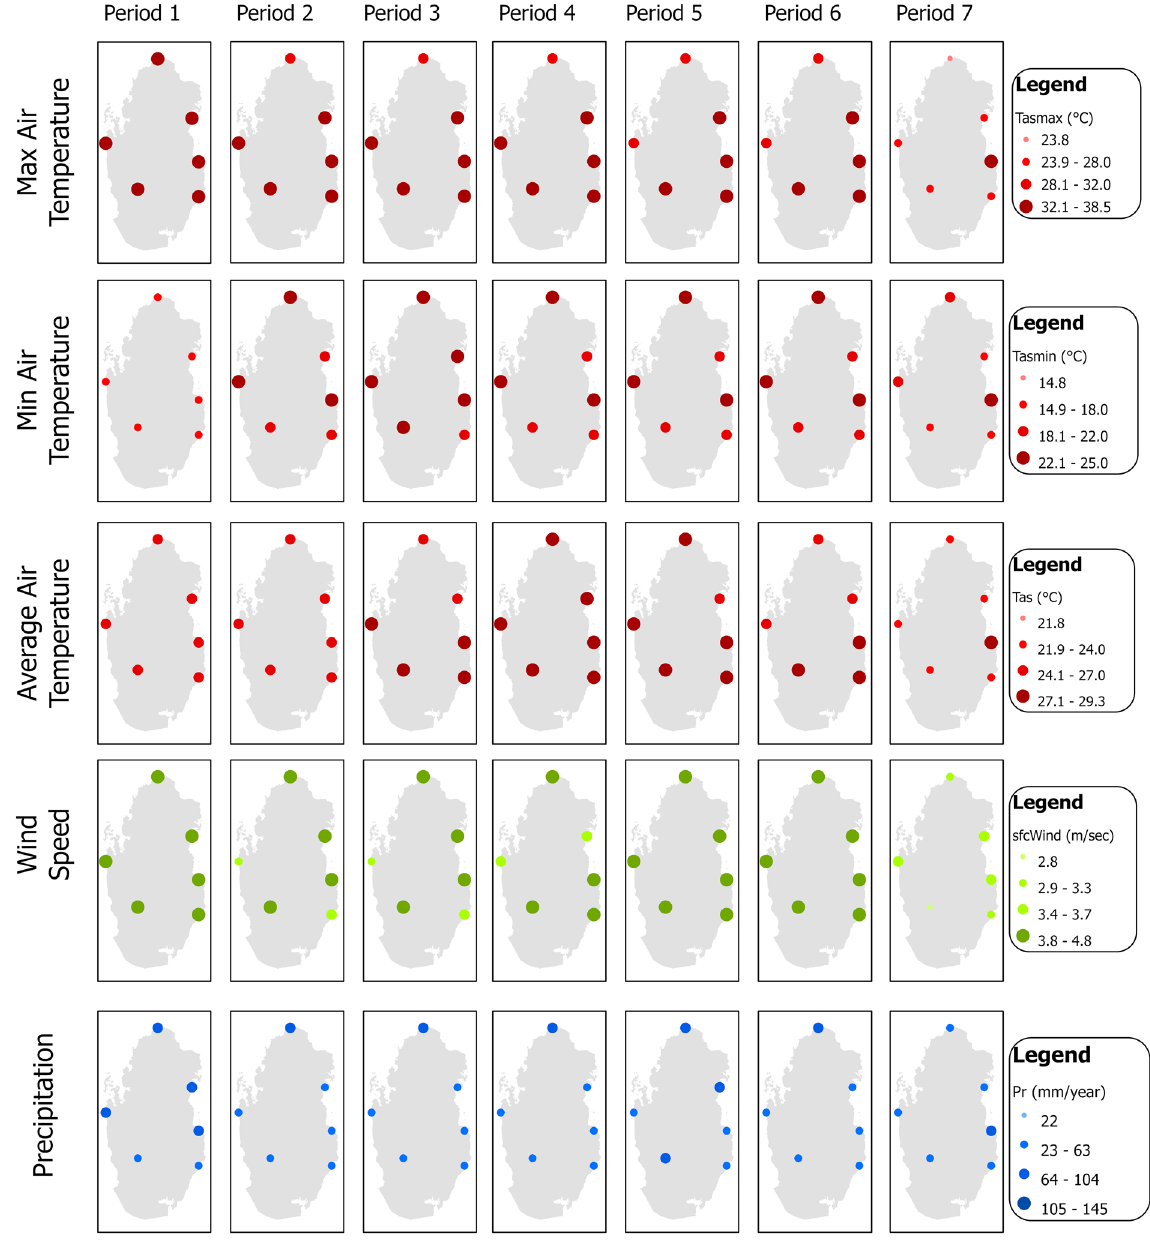
Figure 1. Mean annual climatic observations at Qatar weather